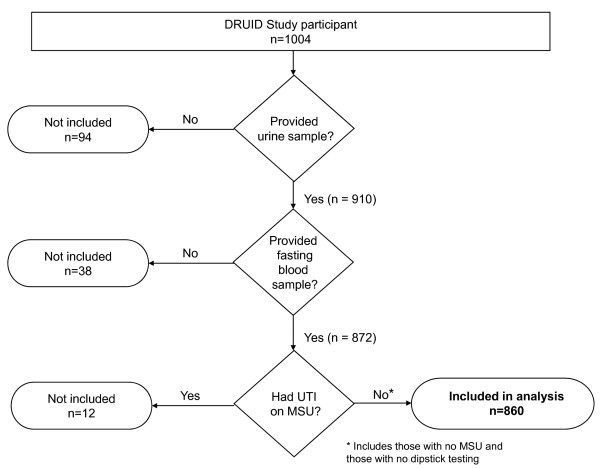
Flow diagram of included DRUID participants.